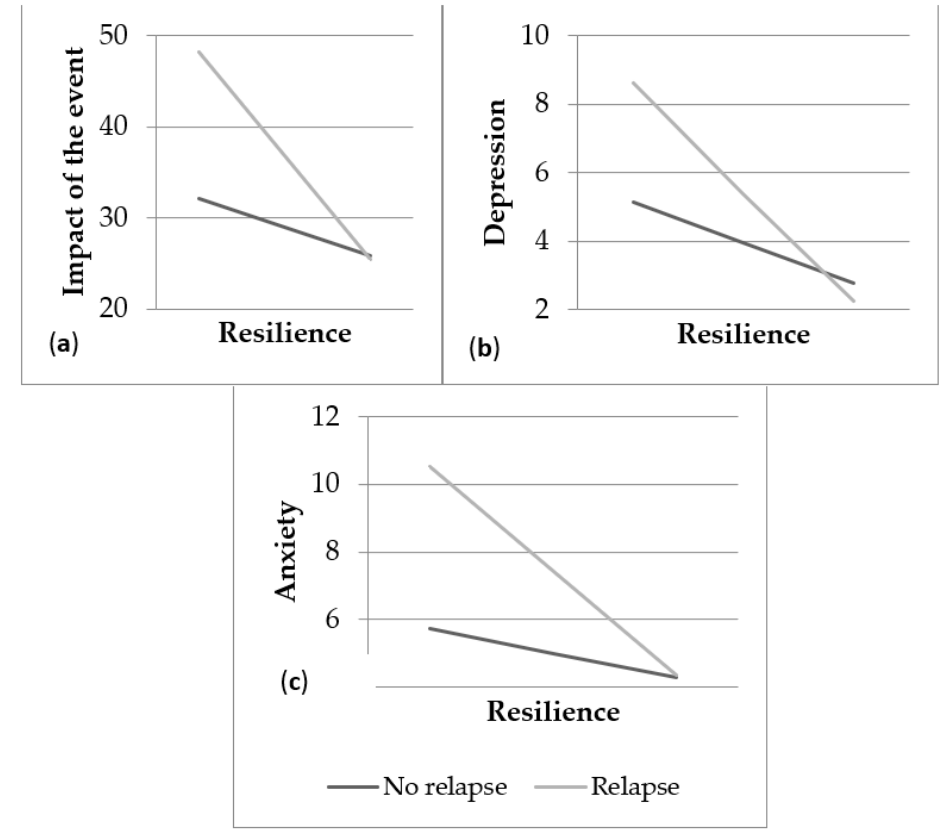
Figure 3. ( a ) Moderation of resilience on the traumatic impact of the event as a function of the presence of relapses; ( b ) moderation of resilience on depression as a function of the presence of relapses; ( c ) moderation of resilience on anxiety as a function of the presence of relapses.